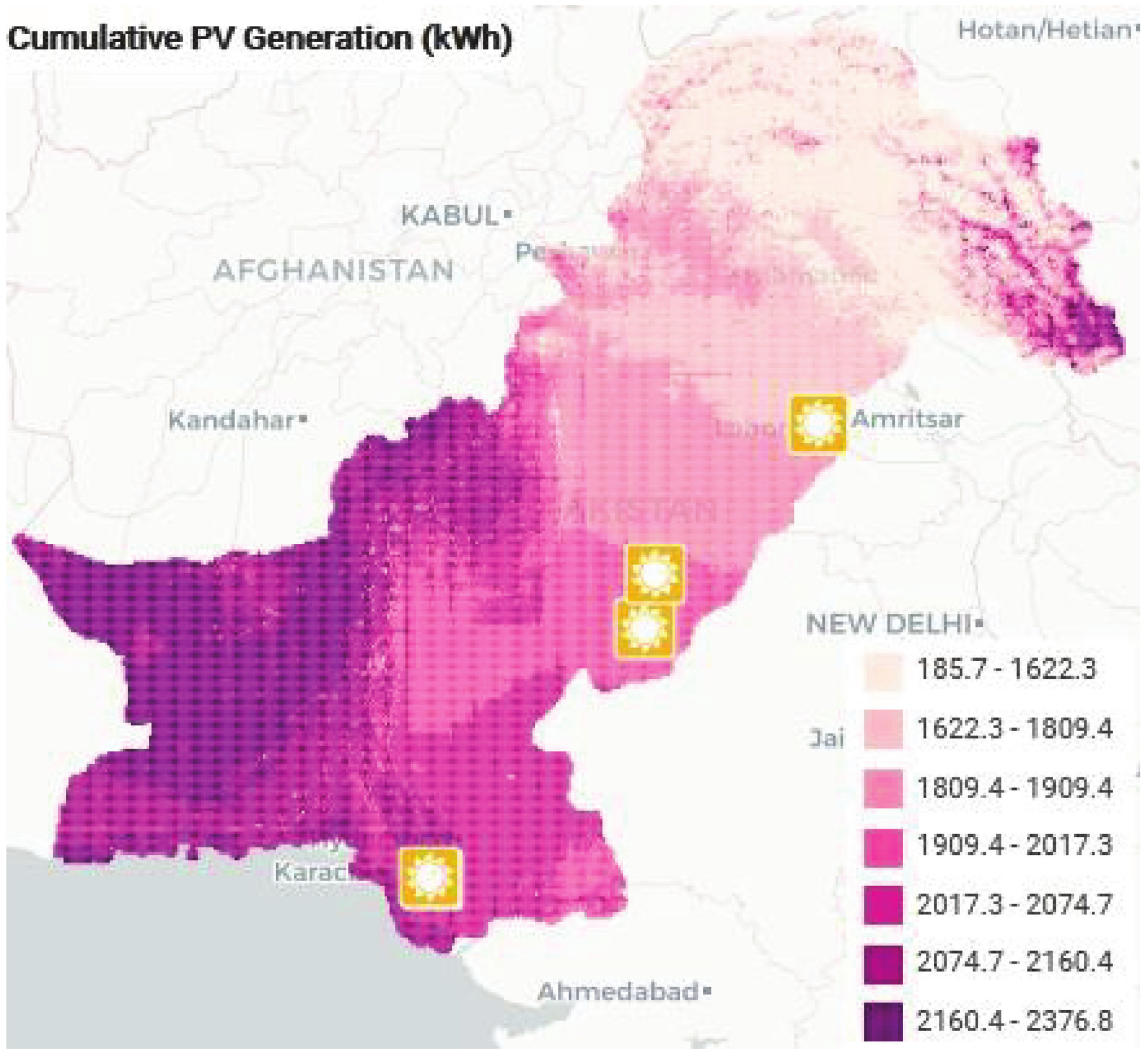
Figure 7: Location of large solar power plants in Pakistan